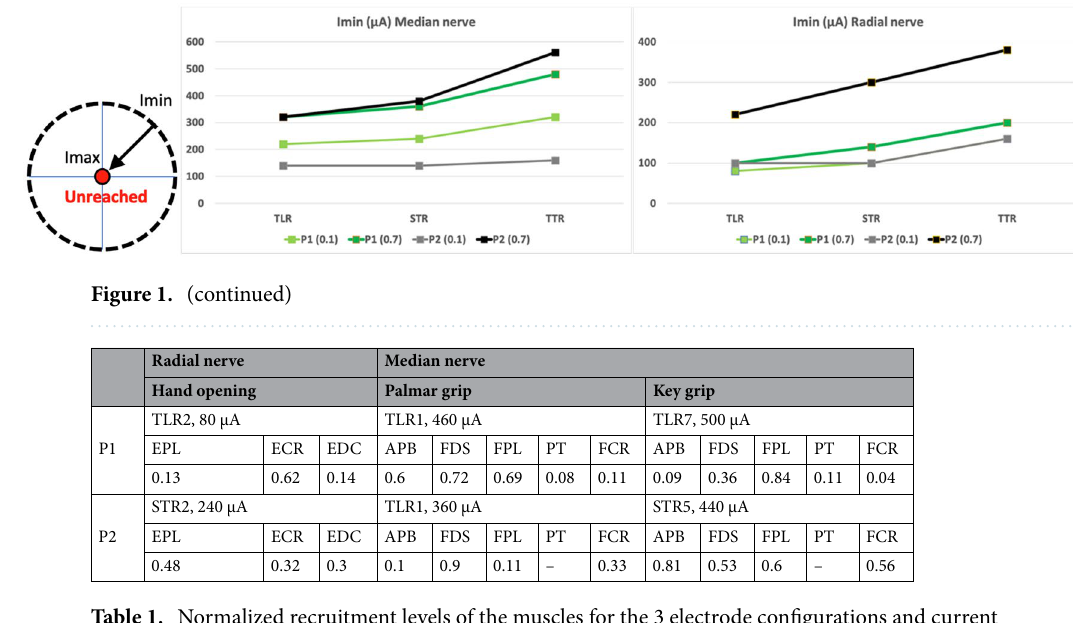
Table 1. Normalized recruitment levels of the muscles for the 3 electrode configurations and current intensities selected to evoke the 3 functional movements. The common stimulation parameters are: frequency 24 Hz and pulse width 150